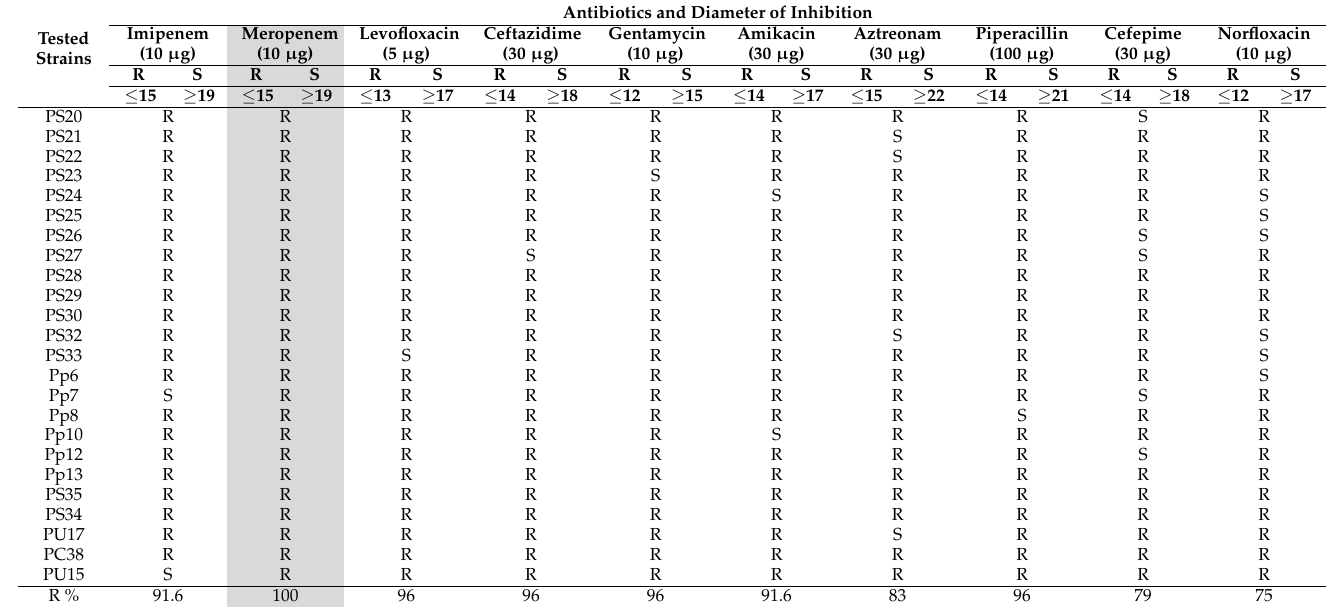
R: resistant; S: sensitive; R%: percentage of resistant strains.